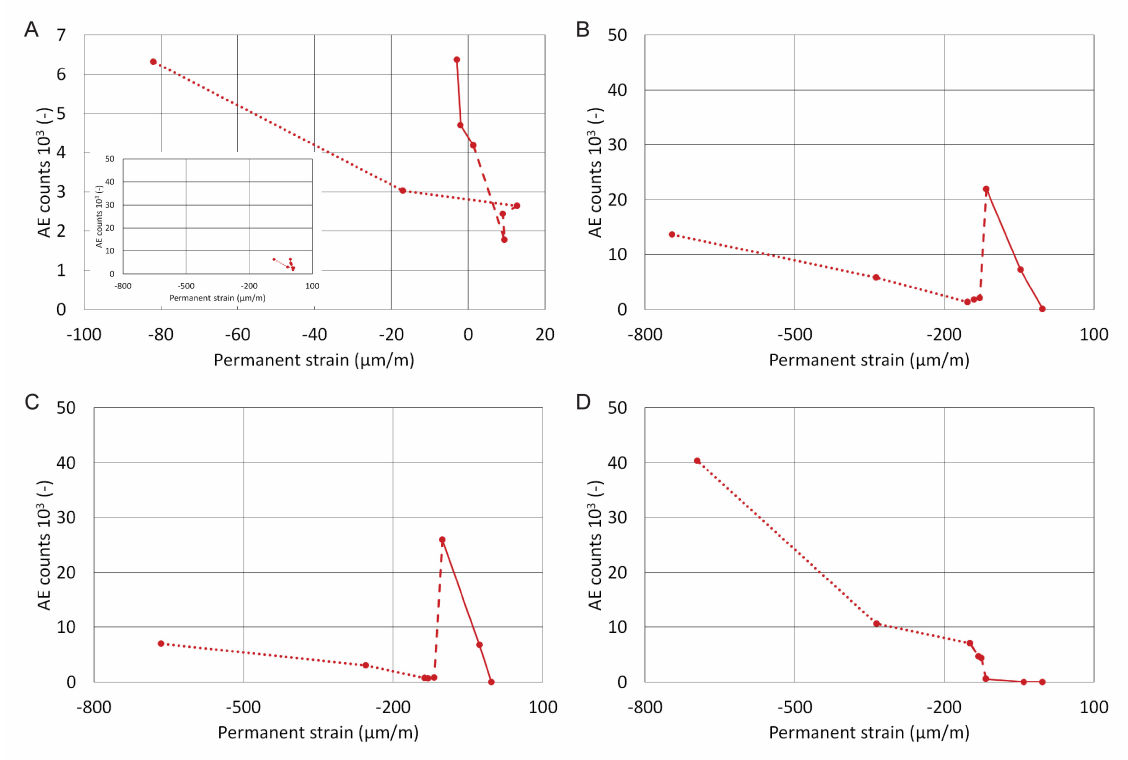
Figure 8. Dependence of AE counts on the permanent strain in ( A ) material system A, ( B ) material system B, ( C ) material system C and ( D ) material system